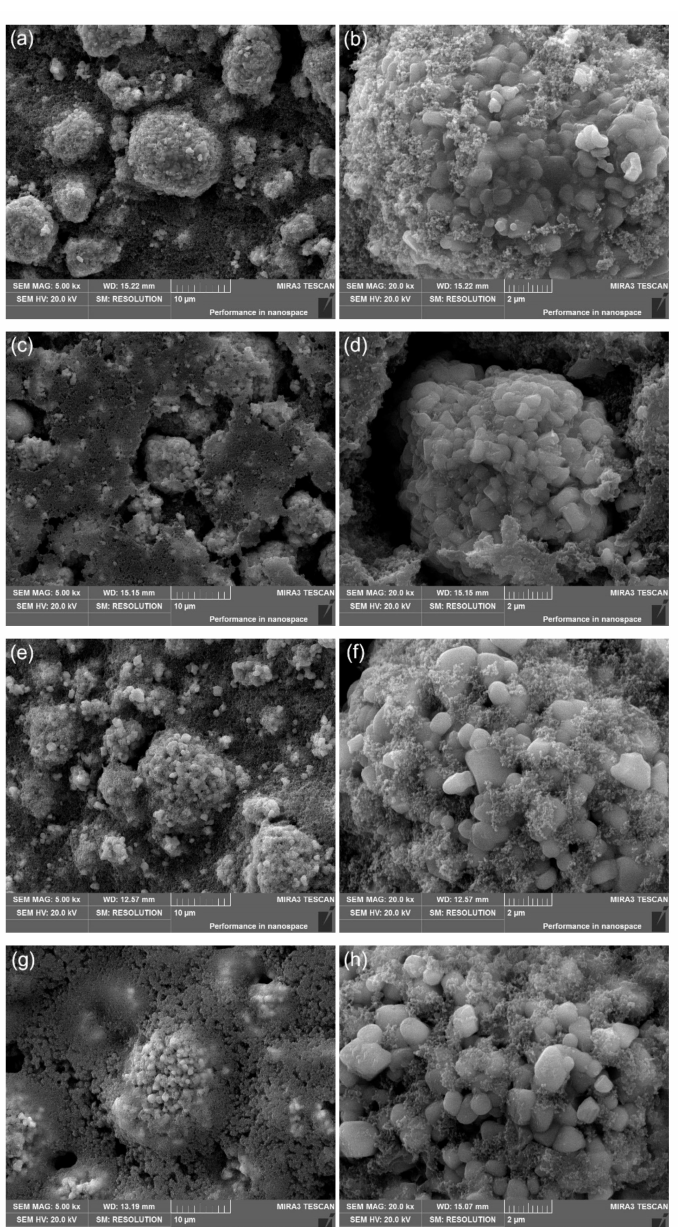
Figure 6. SEM images of the synthesized LiNi 1/3 Co 1/3 Mn 1/3 O 2 electrodes after cycling (100 cycles): ( a , b ) Pristine LNCM before cycling; ( c , d ) Pristine LNCM after cycling; ( e , f ) Cl&Br co-doped LNCM before cycling; ( g , h ) Cl&Br co-doped LNCM after